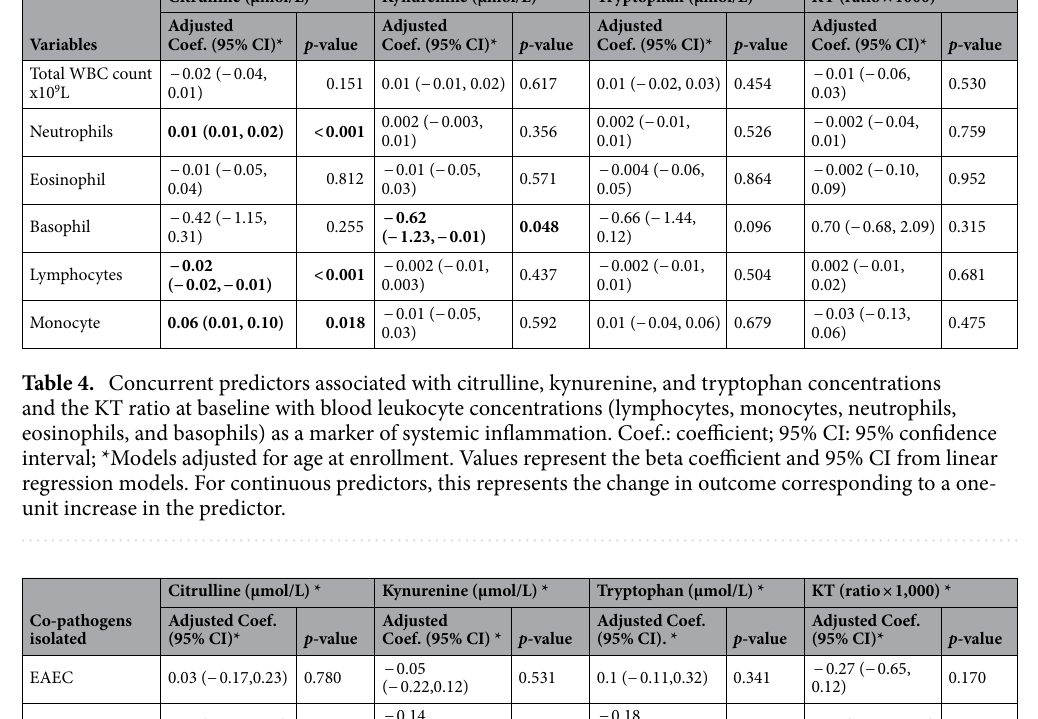
Co-pathogens isolated